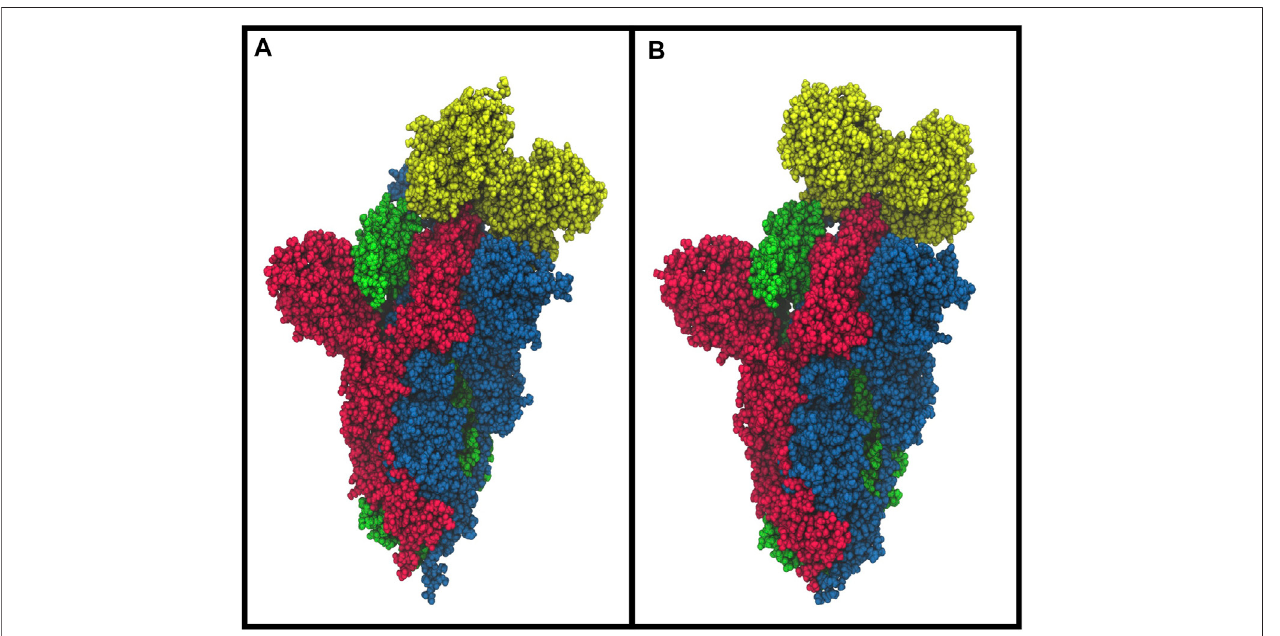
FIGURE 3 | Space- fi ll representations of the best molecular complex obtained with Frodock between the bovine (A) and human (B) lactoferrin with the spike glycoprotein. The red, blue, and green colors represent the spike glycoprotein chains, and while yellow depicts the lactoferrin molecules.